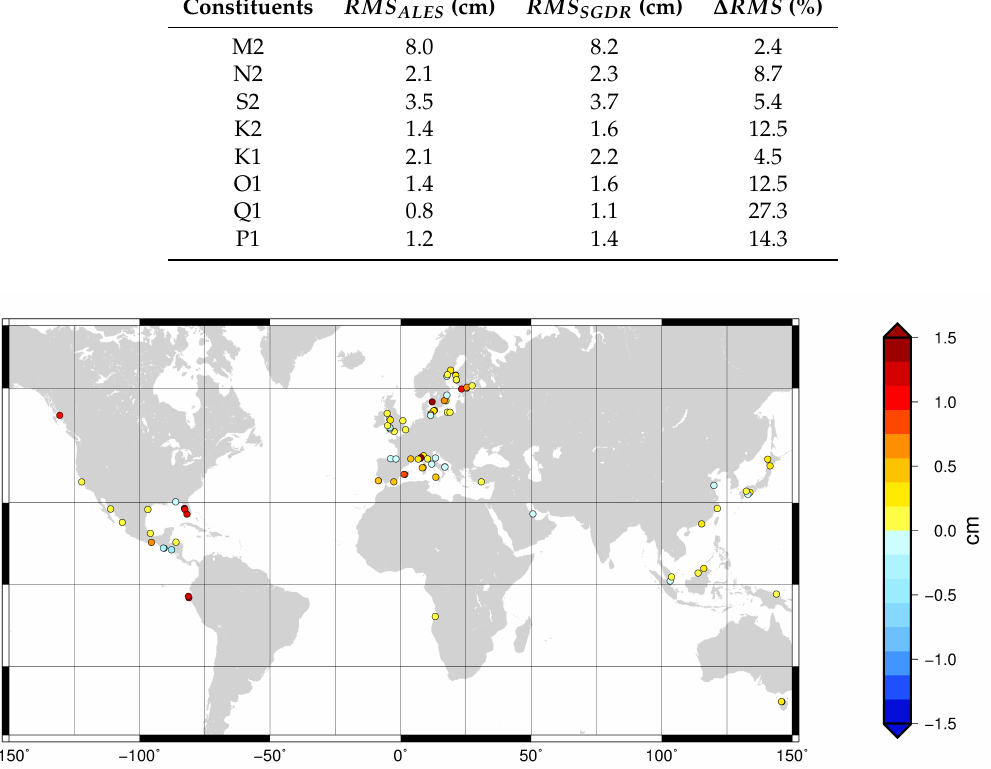
Table 2. Average of RMS for major constituents for the closest points to the tide gauges. The values are expressed in cm. The last column shows the relative difference between the two solutions. Constituents RMS ALES (cm)